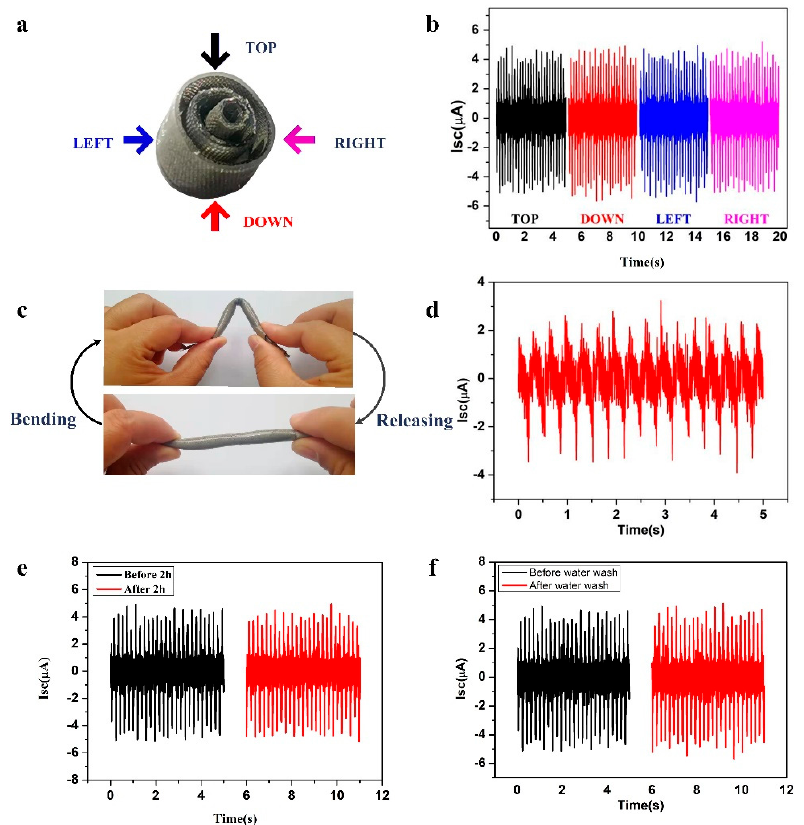
Figure 4. The application performance tests. ( a ) The four di ff erent directions perpendicular to the axial direction of the tube; ( b ) Short-circuit current of the SNTN under four pressure directions; ( c ) Schematic diagram showing that the SNTN can collect bending motion energy; ( d ) Short-circuit current of the SNTN when bent by hand; ( e ) Short-circuit current of the SNTN before and after a 2 h pressure process; ( f ) Short-circuit current of the SNTN before and after immersing in water for 2